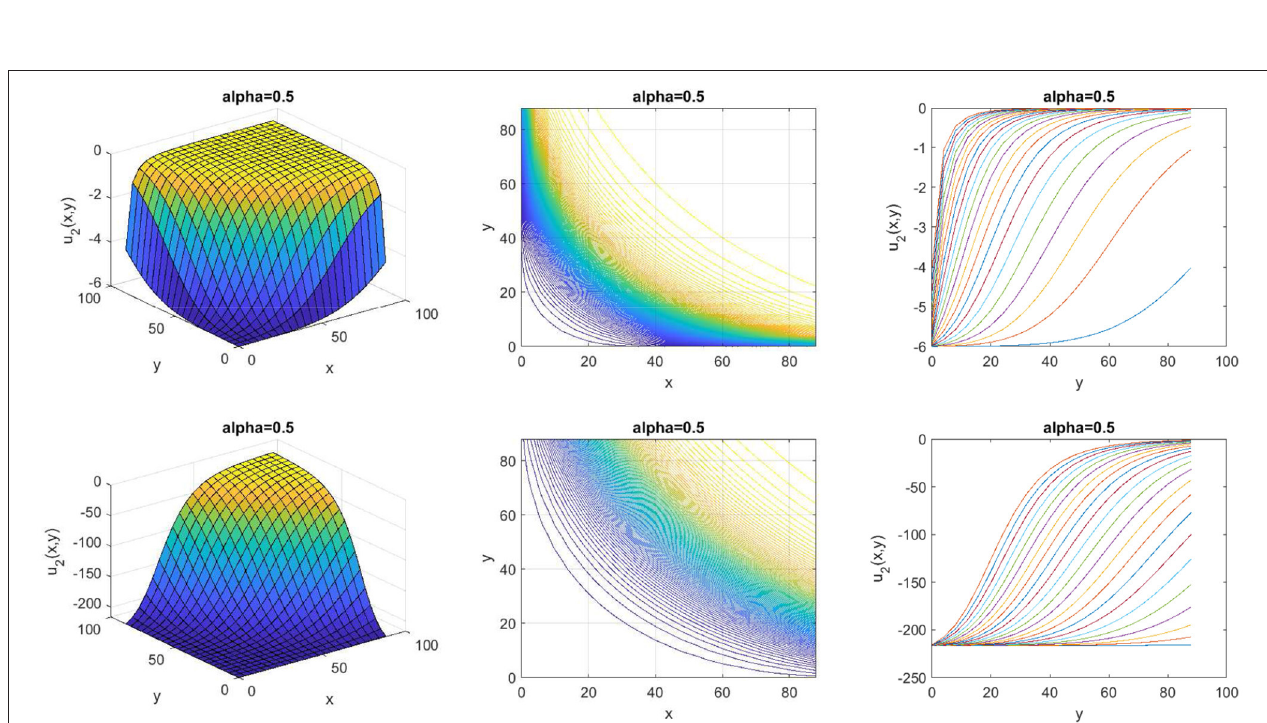
FIGURE 1 | Kink wave solution of Equation (25) in 3D, contour and 2D for Case I.